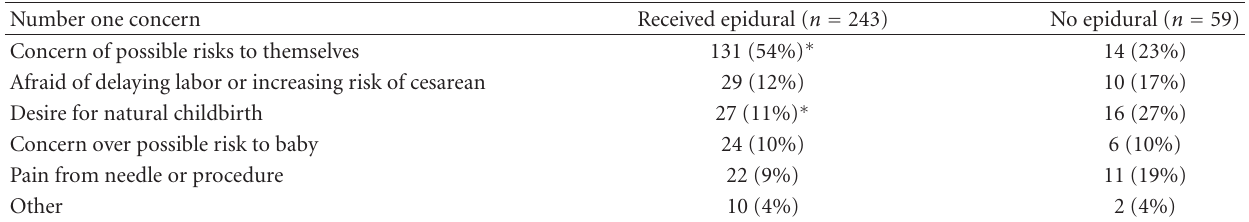
Table 4: Responses to the question. “Before coming to the hospital, what was the number one concern you had regarding epidurals, which may have led you towards avoiding an epidural for labor?”